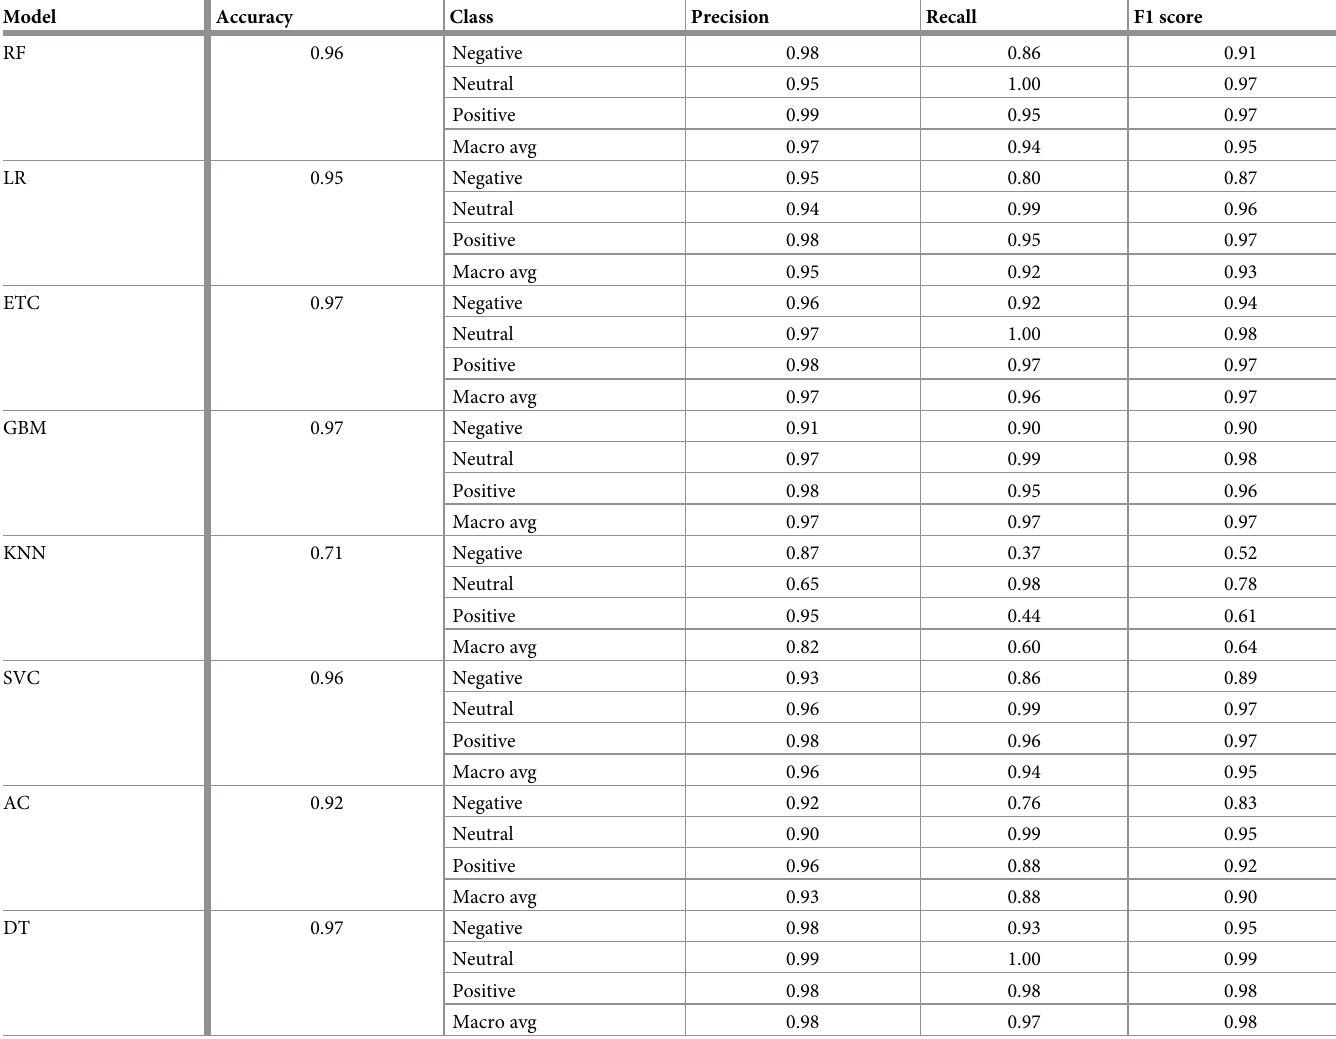
Table 5. Experimental results of machine learning classifiers using BoW